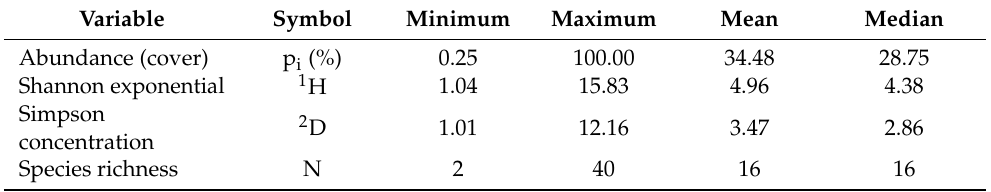
Table 3. Variation in macrophyte diversity indices in the hydromorphologically altered river